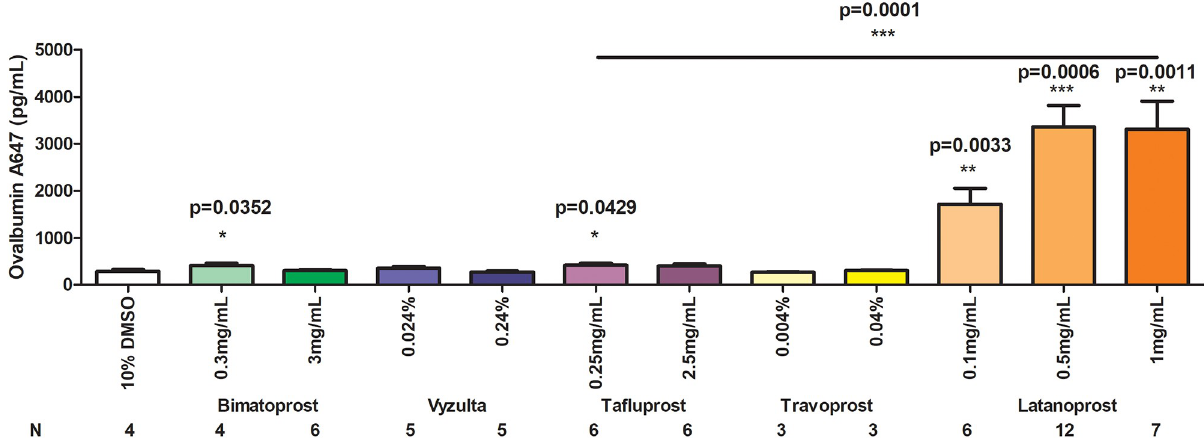
Fig 3. Comparison of the effect of latanoprost intranasal application to other PGF2alpha analogues in the recovery from nasal turbinates of fluorescently tagged ovalbumin after CSF injection after single dose application of each drug. All statistical comparisons are relative to controls except as indicated by the horizontal bar comparing 1 mg/ml latanoprost with 0.25 mg/ml tafluprost; � = p < 0.05, �� = p < 0.01, ��� = p < 0.001.